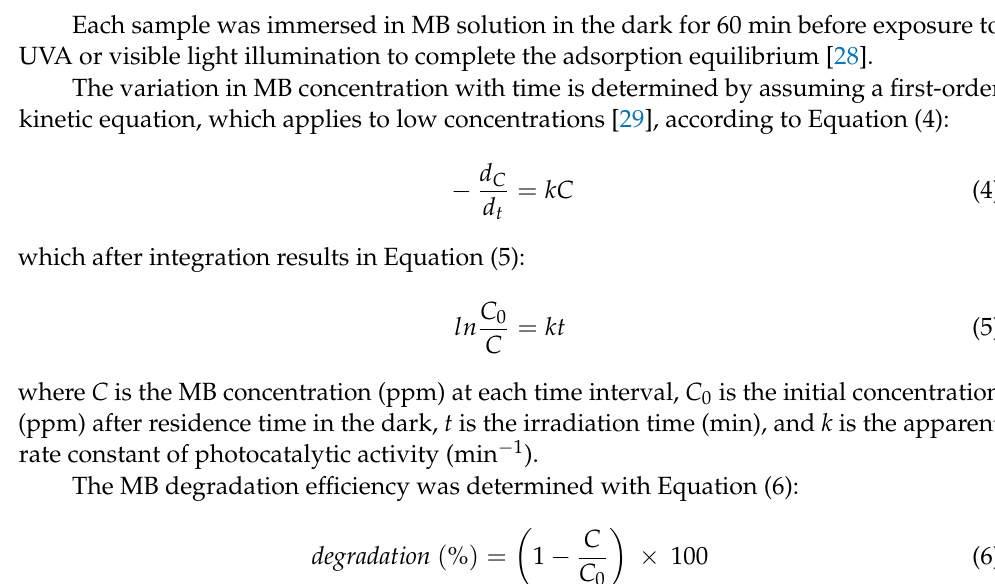
Figure 2. Schematic of the photoreactor.